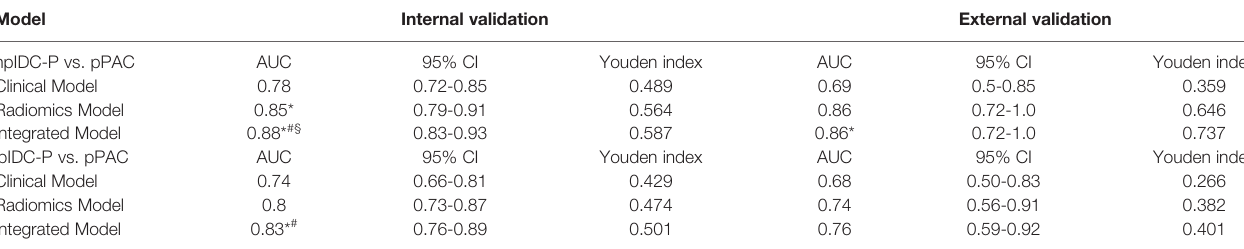
TABLE 2 | The performance of internal and external validation of predicting hpIDC-P and lpIDC-P. Model Internal validation External validation hpIDC-P vs.